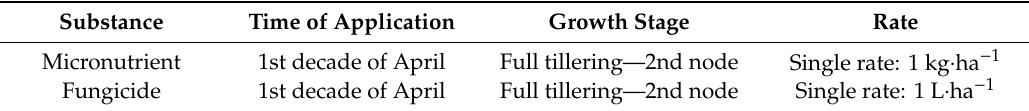
Table 1. Details of the